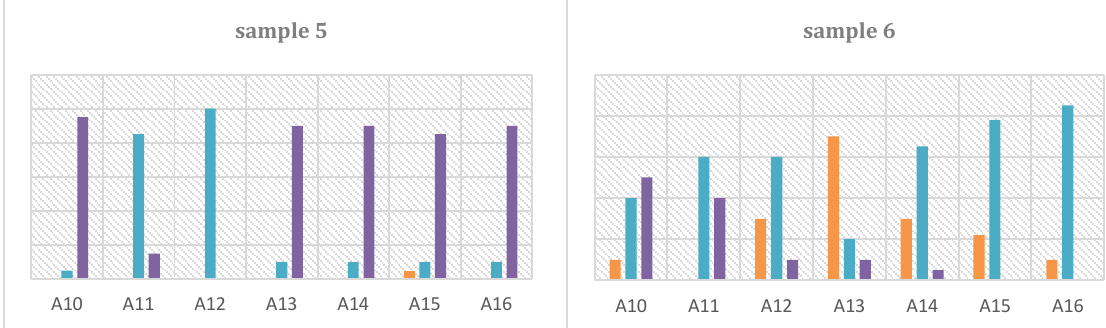
Fig. 13. The proportions of the questionnaire for sample 5.